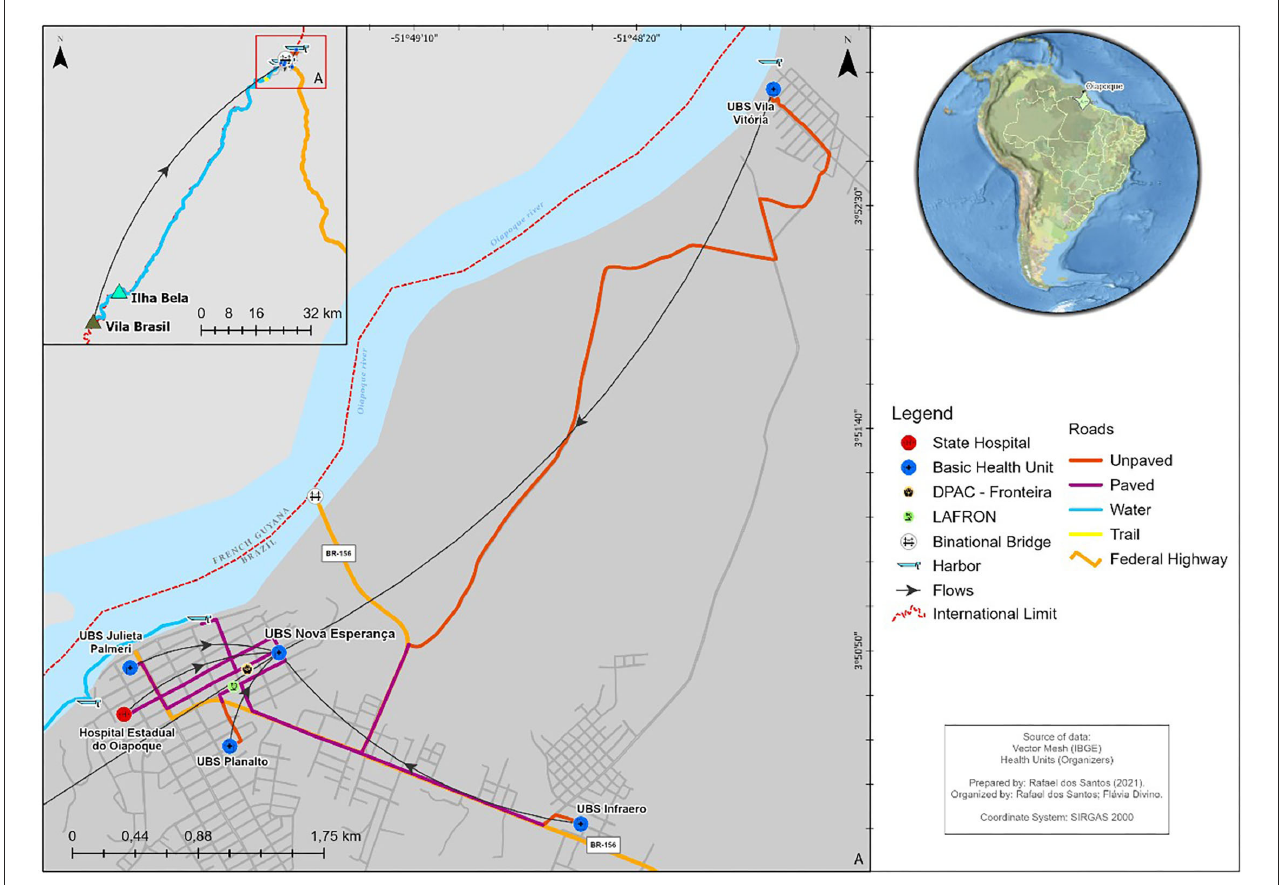
FIGURE3 Routes between the units responsible for the referral and the unit responsible for the treatment.